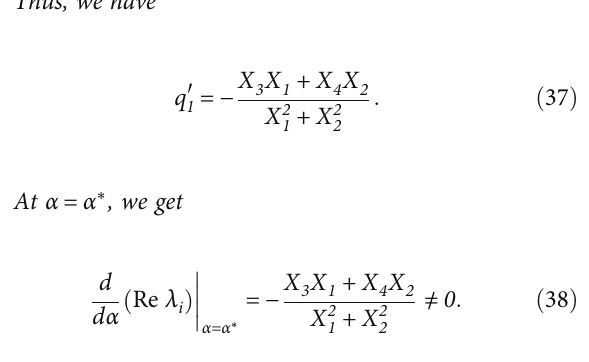
2 with parametric value as in Table 2